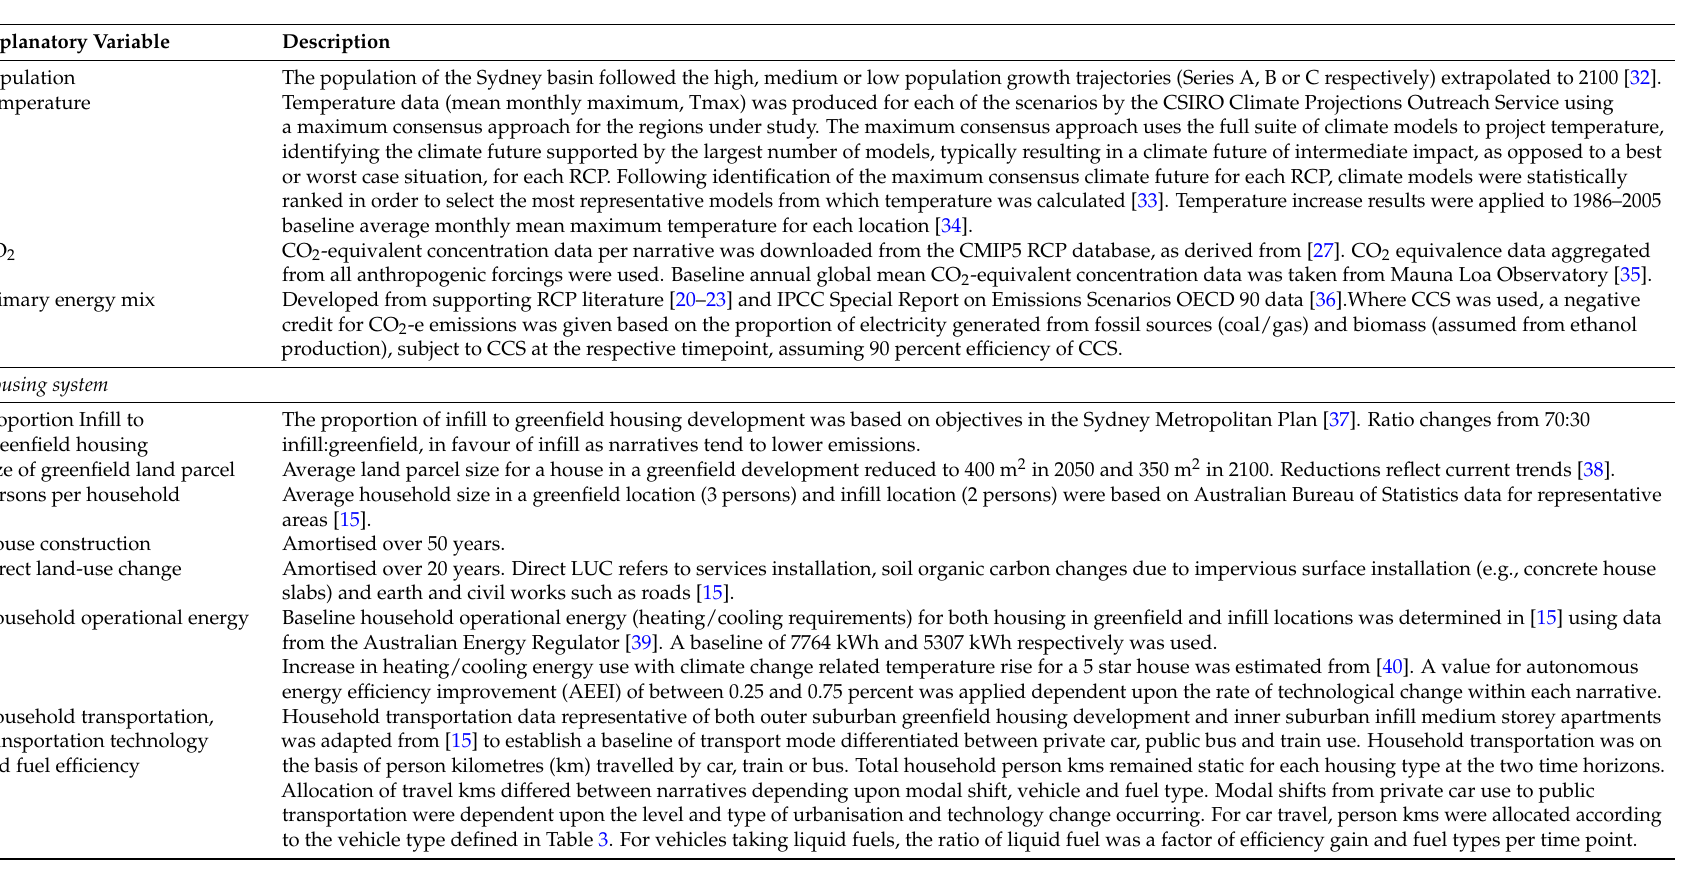
Table 2. Explanatory variables supporting narratives for the four future urban development